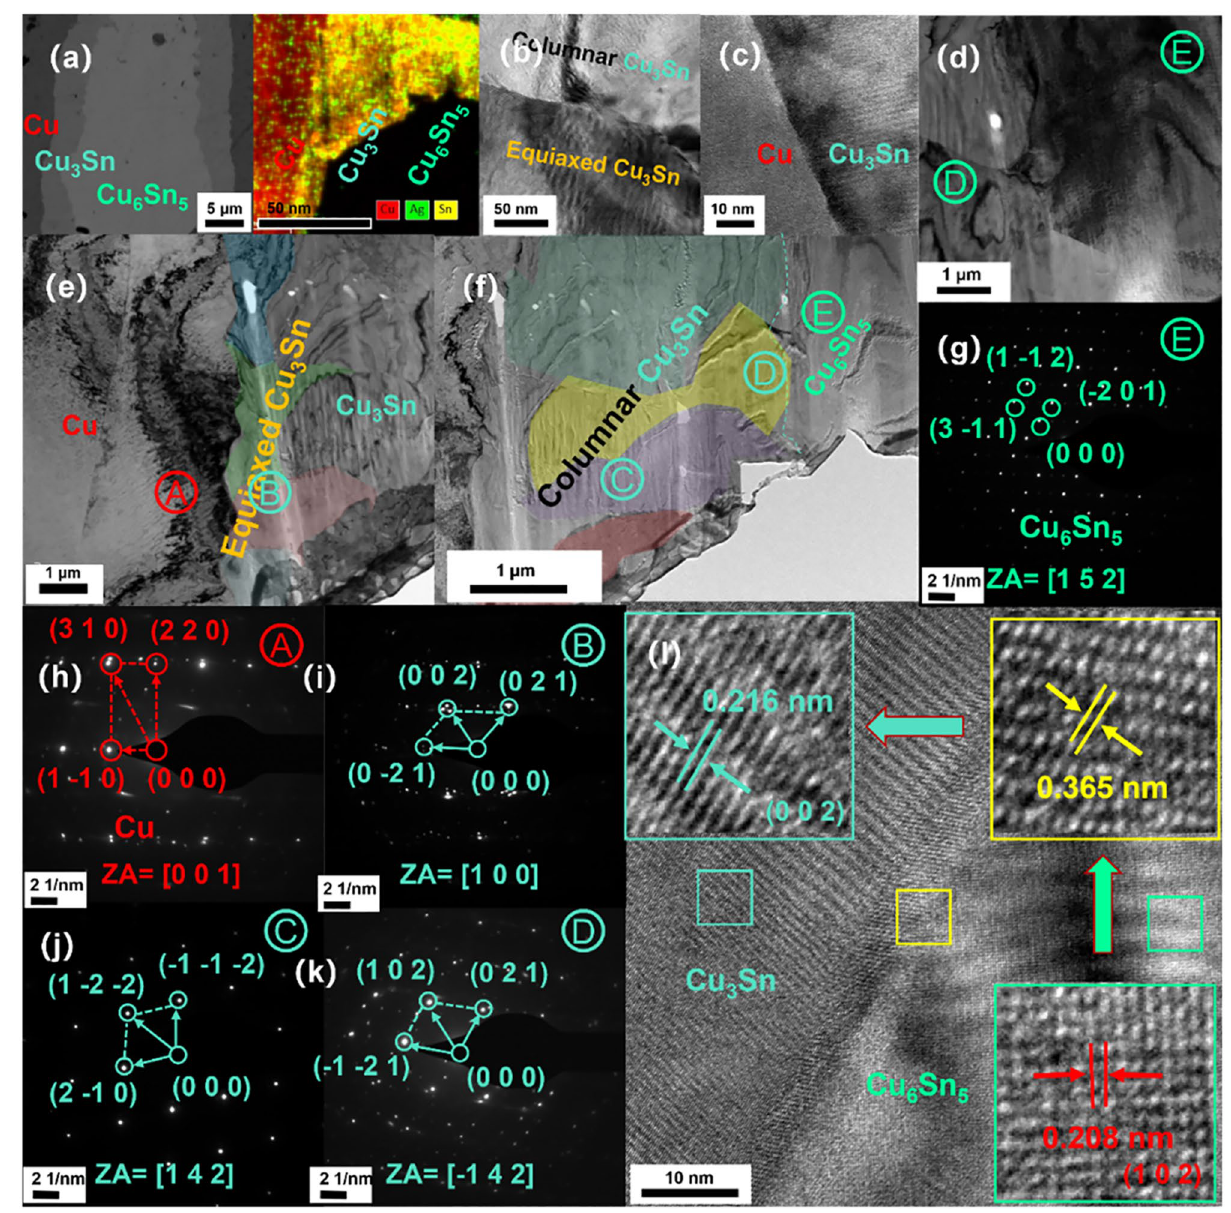
Figure 9. TEM (transmission electron microscope) images of solder joint after reflowing at 280 °C for 30 min ( a ) SEM images at the Cu/Cu 3 Sn/Cu 6 Sn 5 interface. ( b ) TEM images at the Cu 3 Sn/Cu 3 Sn interface. ( c )The high- resolution images at the Cu/Cu 3 Sn interface. ( d ) TEM images at the Cu 3 Sn/Cu 6 Sn 5 interface. ( e ) TEM images of equiaxed Cu 3 Sn. ( f ) TEM images of columnar Cu 3 Sn. ( g ) The electron diffraction pattern of the Cu 6 Sn 5 . ( h ) The electron diffraction pattern of the Cu ( i ) The electron diffraction pattern of the Cu 3 Sn. ( j ) The electron diffraction pattern of the Cu 3 Sn. ( k ) The electron diffraction pattern of the Cu 3 Sn. ( l ) The high-resolution images at the Cu 6 Sn 5 /Cu 3 Sn The equiaxed Cu 3 Sn grain nucleates at the Cu/Cu 3 Sn interface have an Orientation Relationship with the Cu substrate. Columnar Cu 3 Sn grains at the Cu 6 Sn 5 /Cu 3 Sn interface have an Orientation Relationship with Cu 6 Sn 5 . This confirms the previous conclusion. After reflowing, the solder joints transformers to a single-phase Cu 3 Sn IMC. Shear experiments on the joints reveal recorded a shear strength of approximately 63.2 MPa and 65.2 MPa at room temperature and 300 °C, respectively.